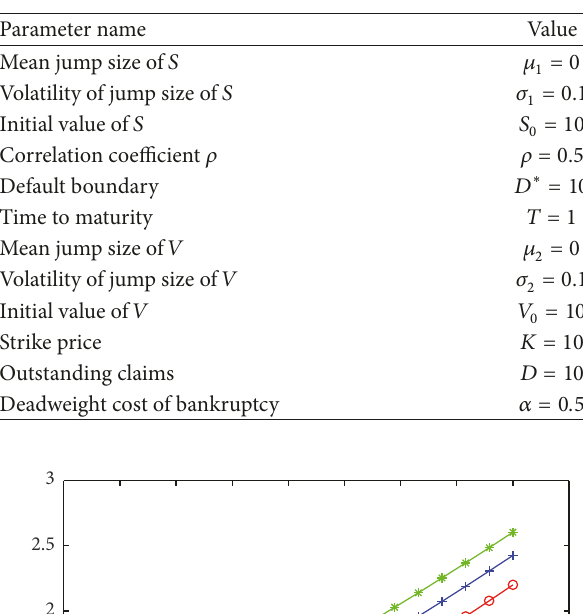
Table 1: Parameters that are independent of the Markov chain.